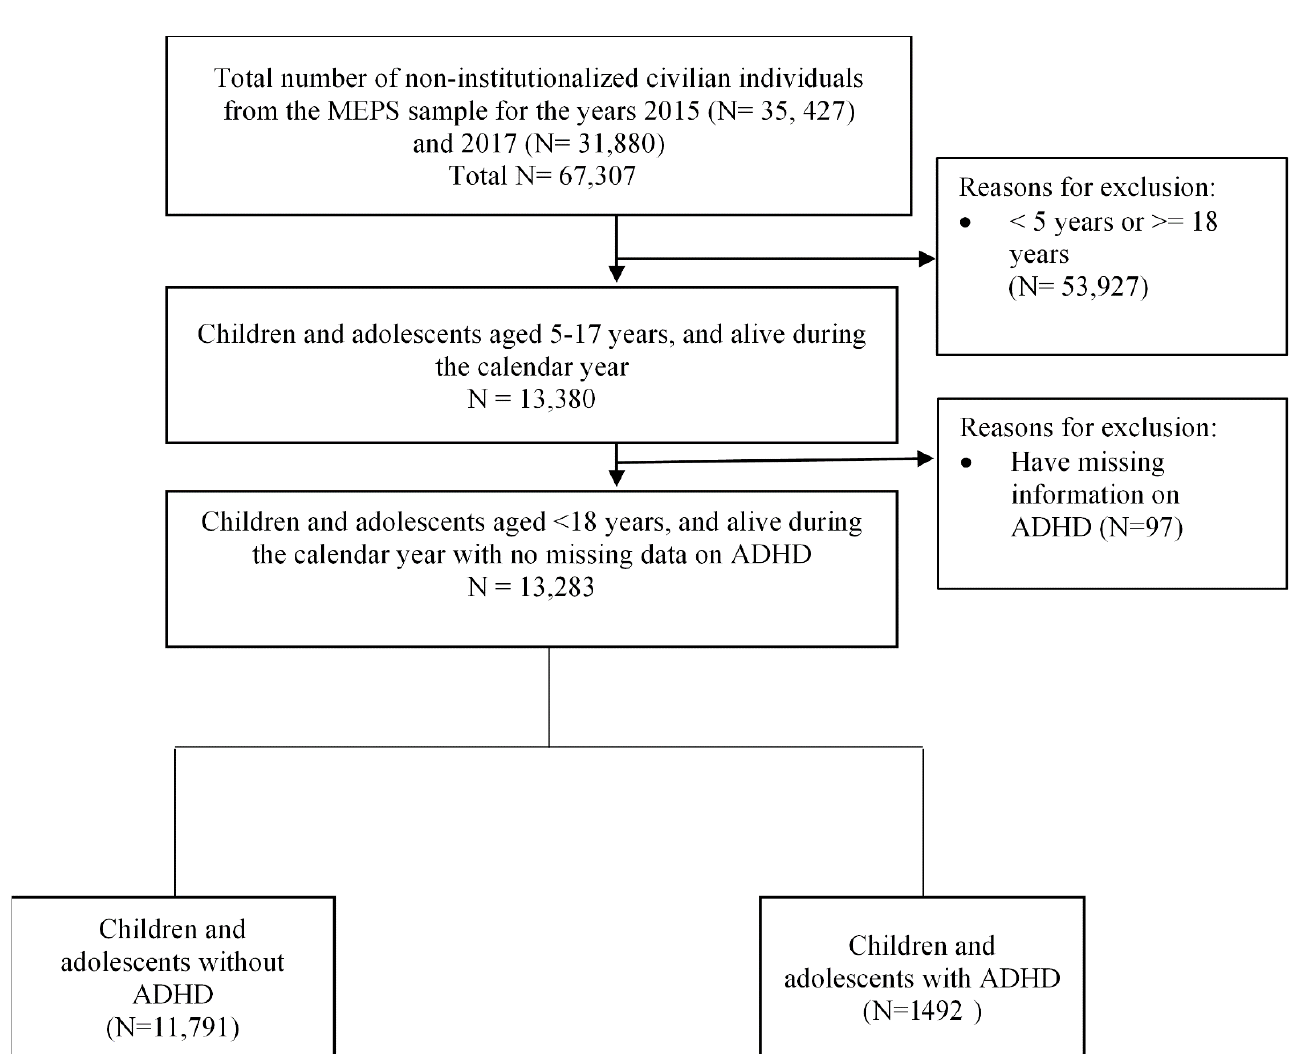
Figure 1. Flow diagram of study sample.